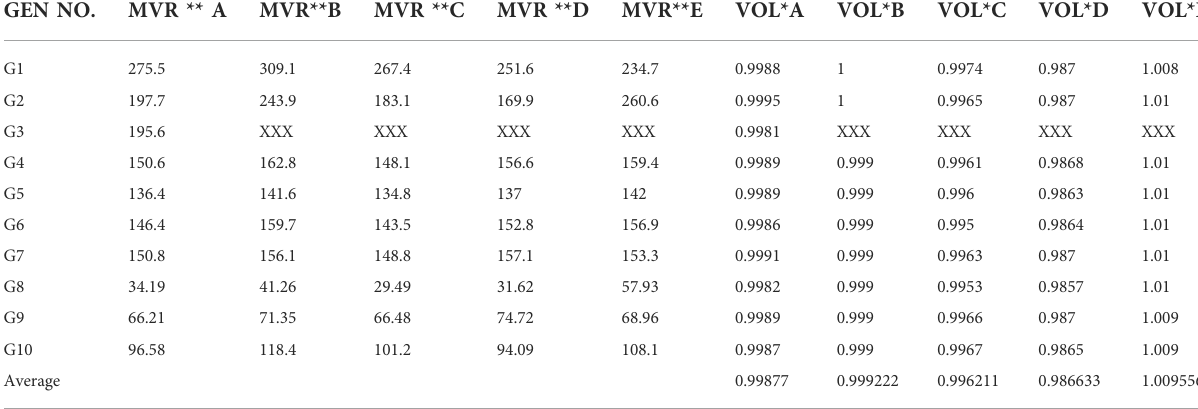
TABLE 4 Reactive power delivery and generator terminal voltage under all conditions of generator G 3 outage. GEN NO.